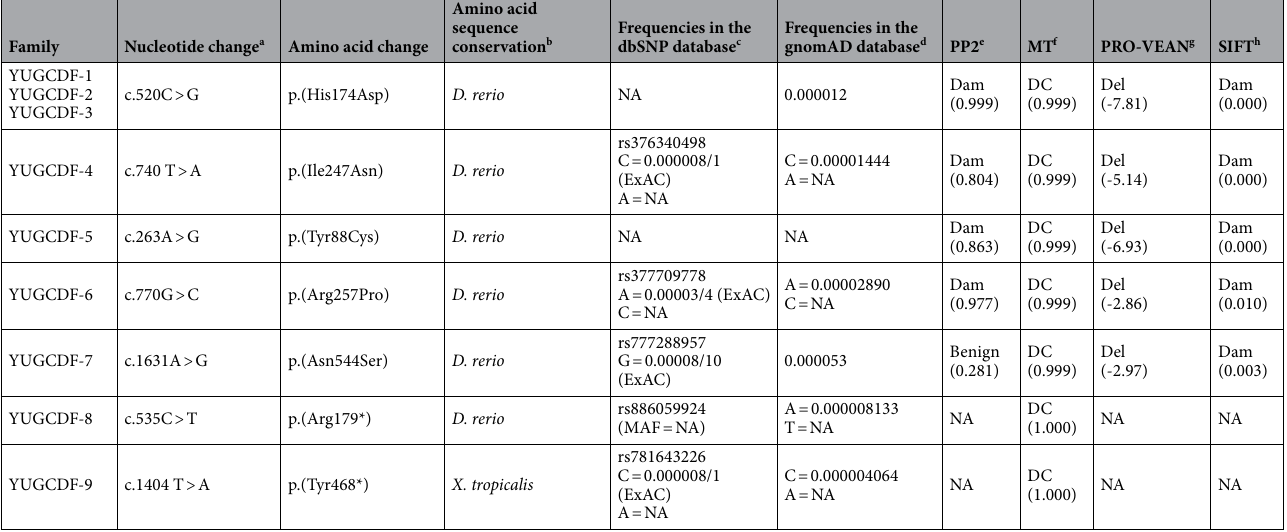
Table 1. Detected mutations increasing severity of granular corneal dystrophy 2 as a compound heterozygote with p.(Arg124His) in this study. Abbreviations: Dam, damaging; DC, disease causing; Del, deleterious; MAF, minor allele frequency; MT, mutation taster; NA, not available; PP2, PolyPhen-2 prediction score Humvar; PROVEAN, Protein Variation Effect Analyzer; SIFT, Sorting Intolerant from Tolerant; SNP, single nucleotide polymorphism. a cDNA mutations are numbered according to the human cDNA reference sequence NM_004183; + 1 corresponds to the A of ATG translation initiation codon. b Amino acid residue is